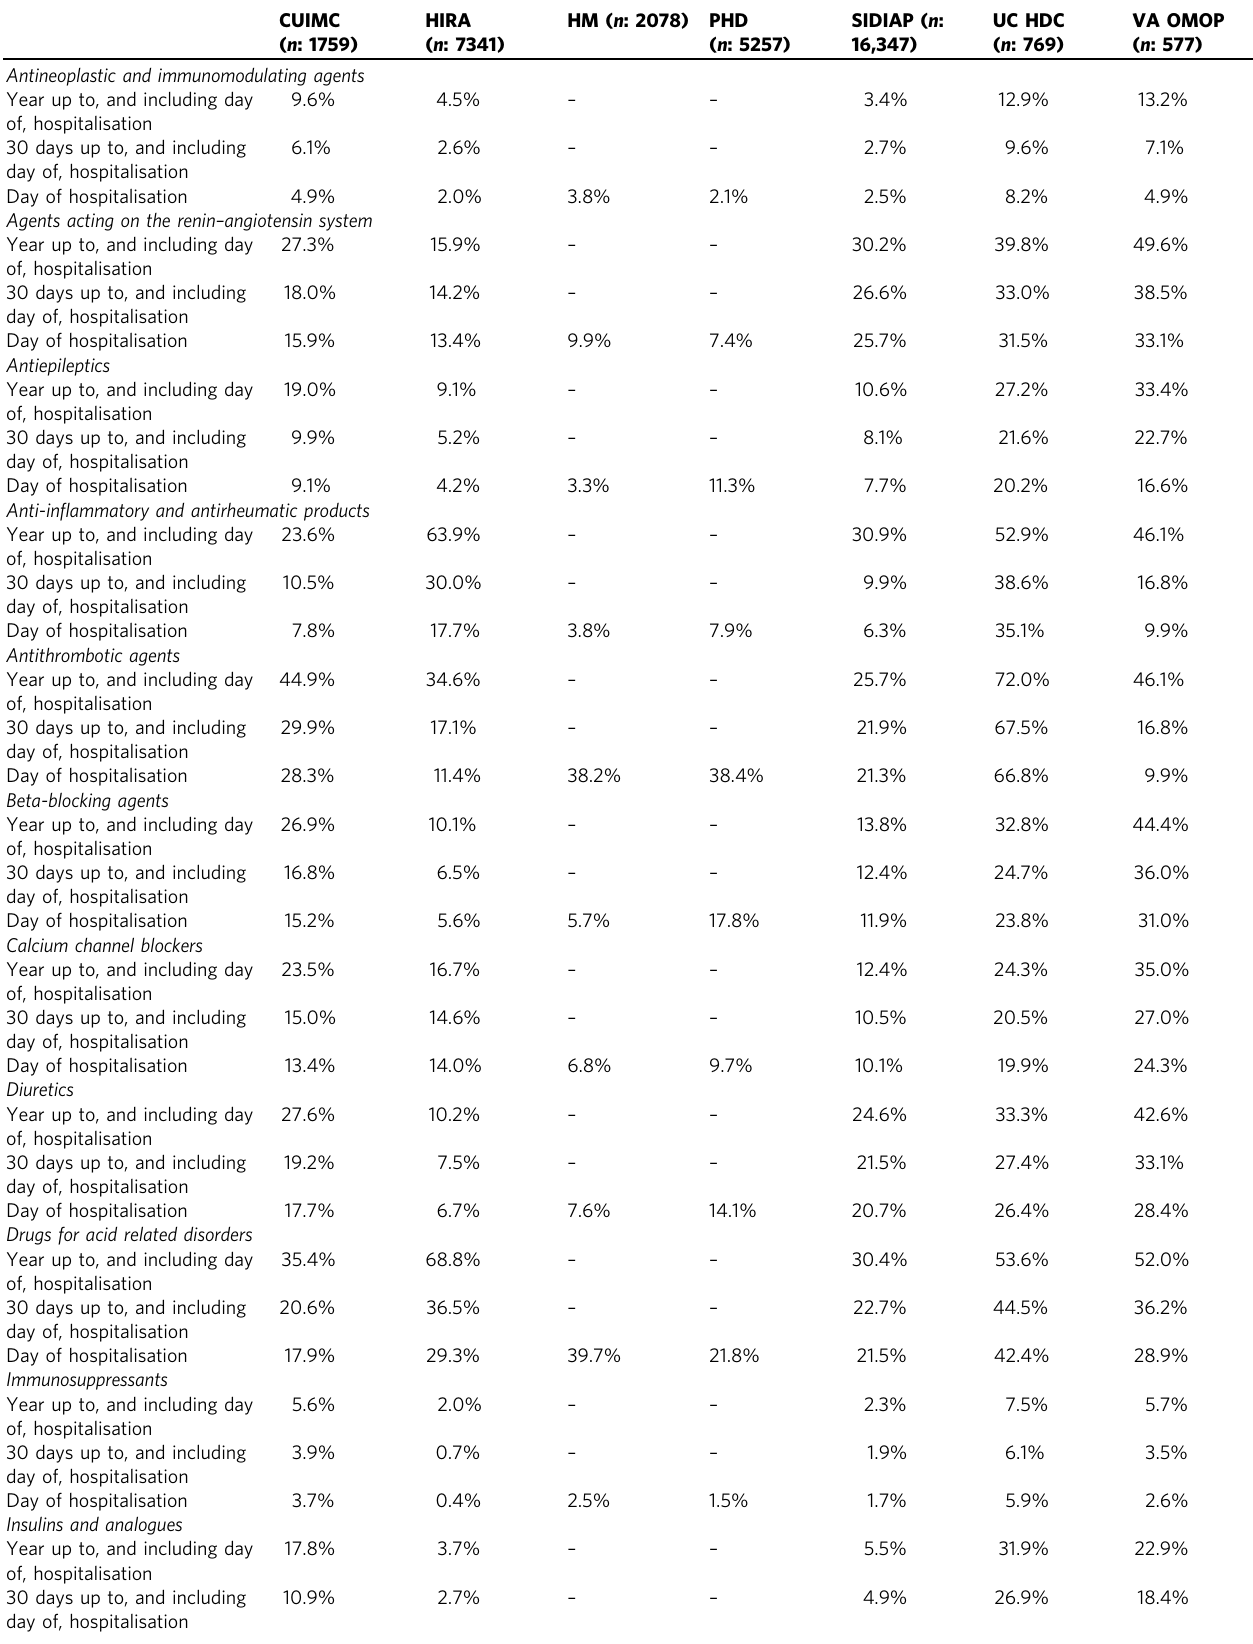
Table 2 Prior medications of individuals hospitalised with